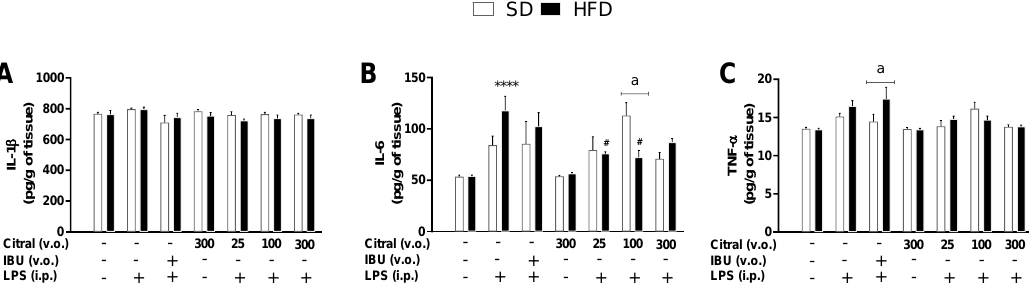
Figure 2. Effect of citral on the hypothalamic cytokine levels in eutrophic (SD) and obese (HFD) mice during systemic inflammation (SI). Hypothalamic levels of IL-1 β ( A ), IL-6 ( B ), and TNF- α ( C ) after 90 min of LPS injection. The results are presented as mean ± SEM for n = 5–7 per group. One-way ANOVA followed by Tukey’s test; **** p < 0.001 vs. Tween 80 + saline; # p < 0.05 vs. Tween 80 + LPS. Two-way ANOVA followed by Bonferroni test; a = p < 0.05, compared to the SD mice.